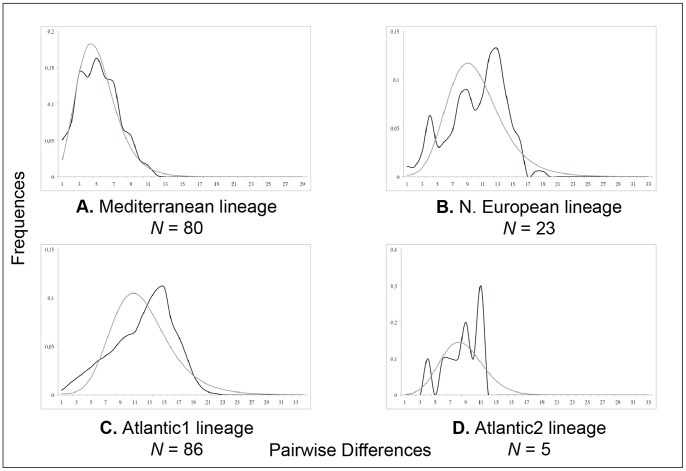
Demographic history of Pomatoschistus microps inferred from concatenated control region and cytochrome b gene sequences.Observed mismatch distributions (grey line) for each lineage are compared to expected distributions (black line) under a population growth-decline model.